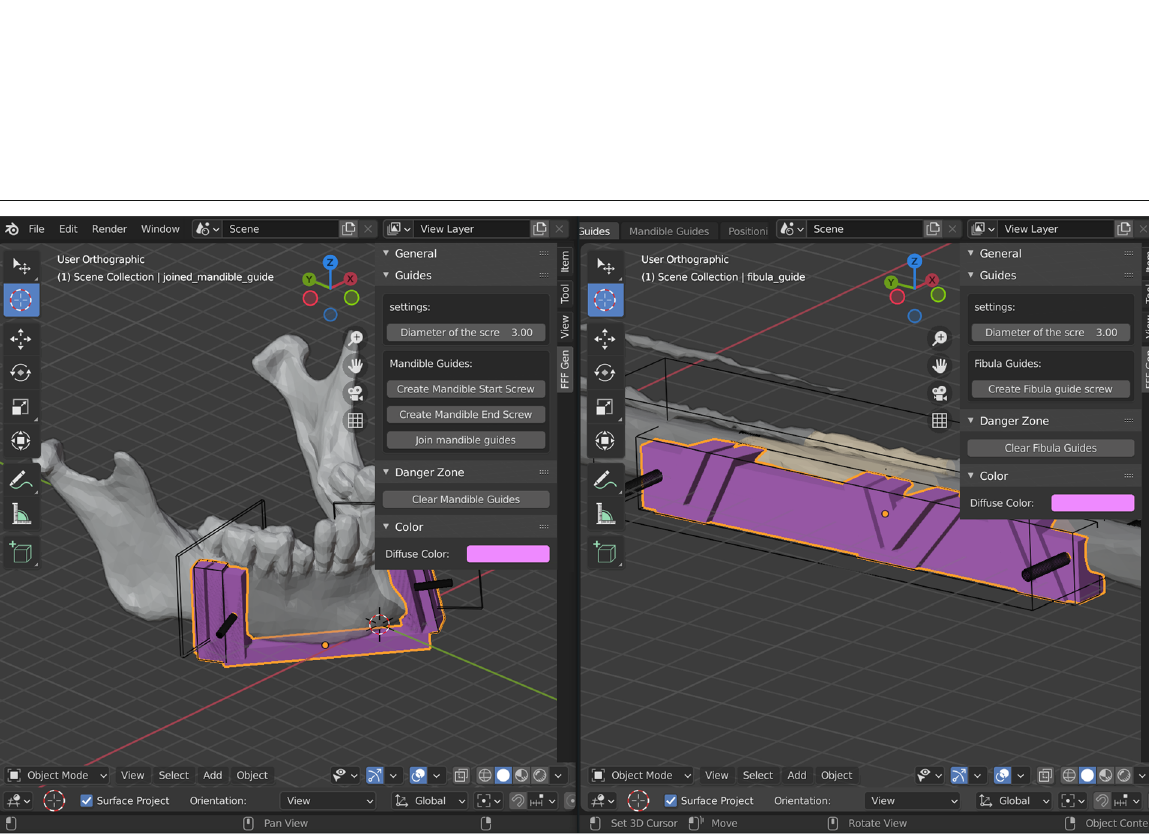
Fig. 3 Generation of the fibula and mandible cutting guide